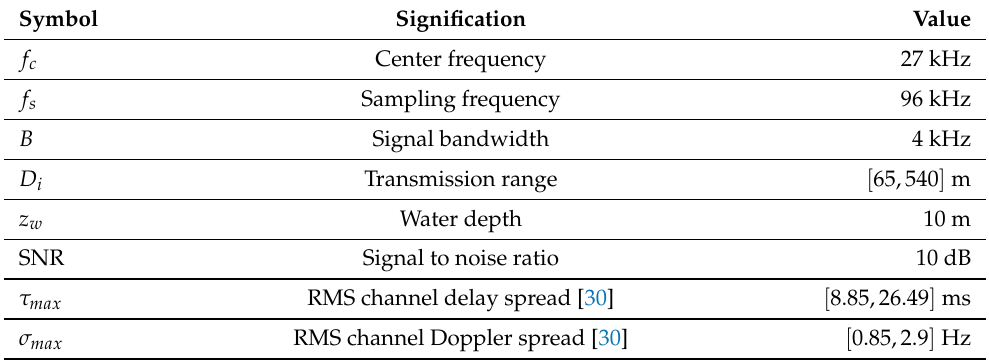
Table 1. Watermark channel